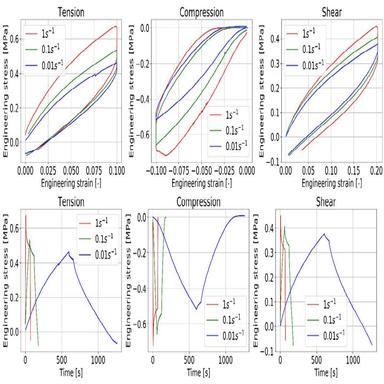
tress-strain and stress-time curves obtained from experiments